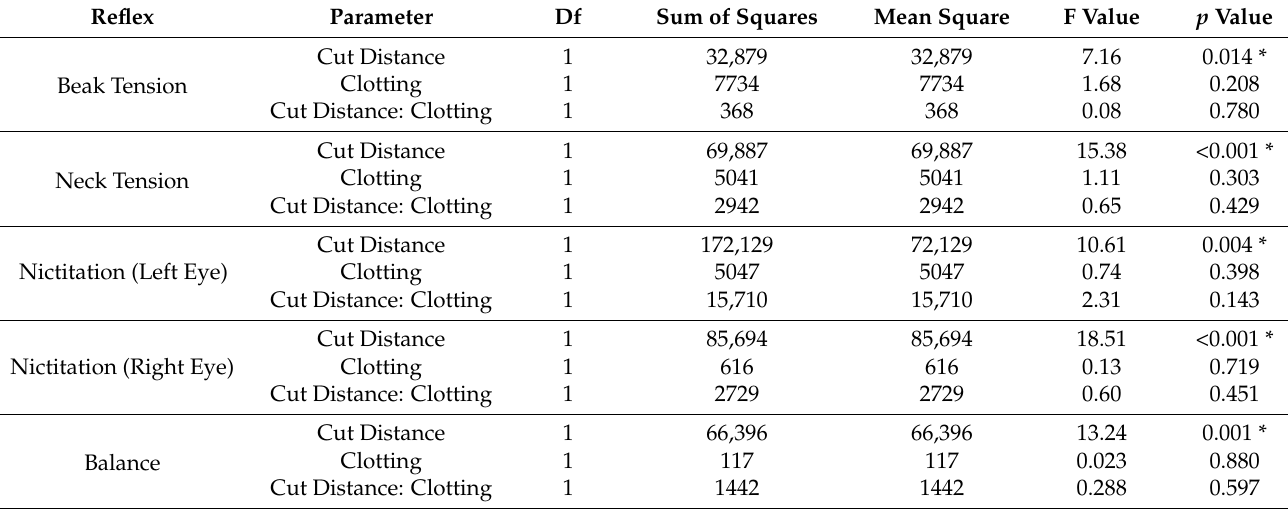
Table 4. Relationship between behavioral and brainstem reflexes and neck cut distance and clotting ( n = 34), values marked with a * are significantly different at p < 0.05